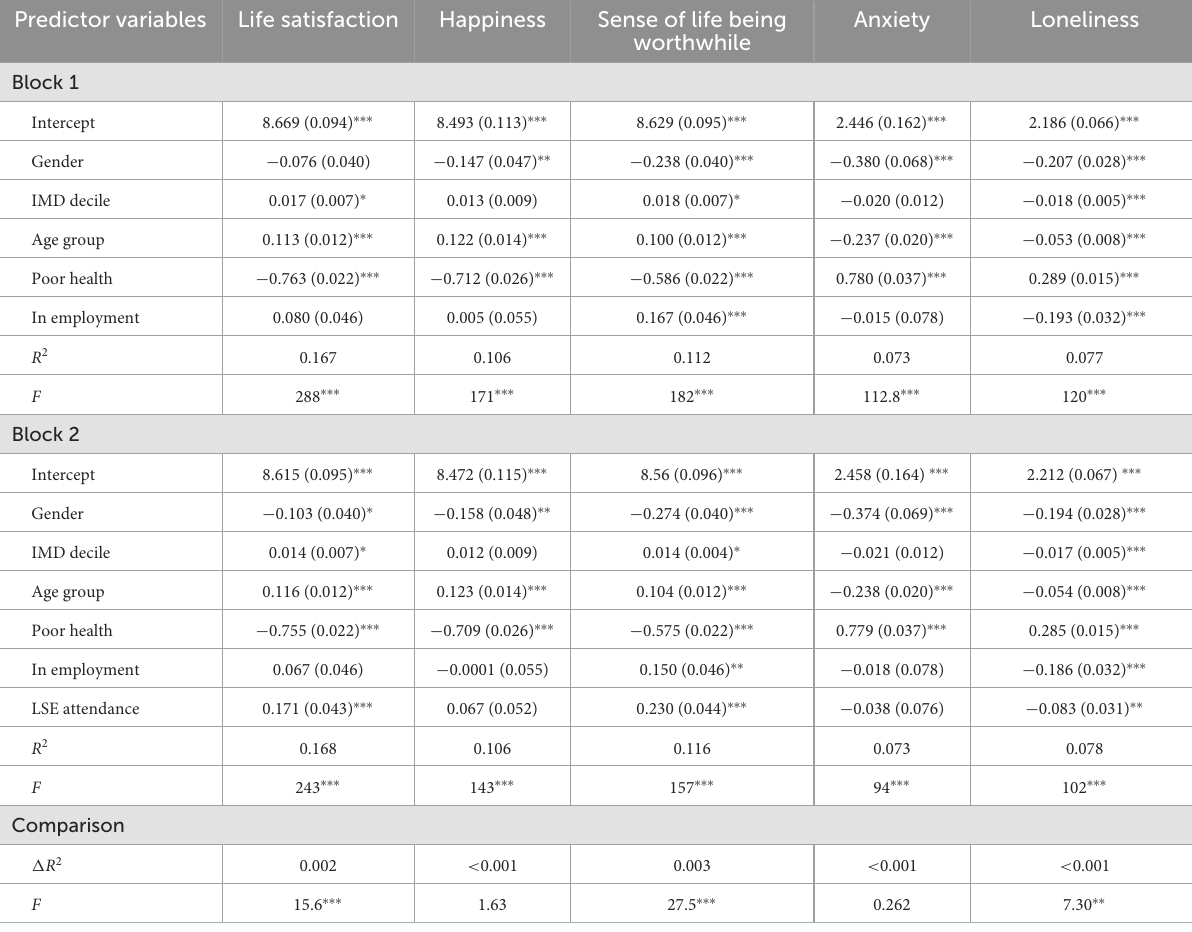
TABLE 2 Co-efficient (standard error) from hierarchical multiple regressions predicting satisfaction, happiness, sense of life being worthwhile, anxiety and loneliness with regression coefficients ( β ) specified for all predictor variables at each block of the regression. Predictor